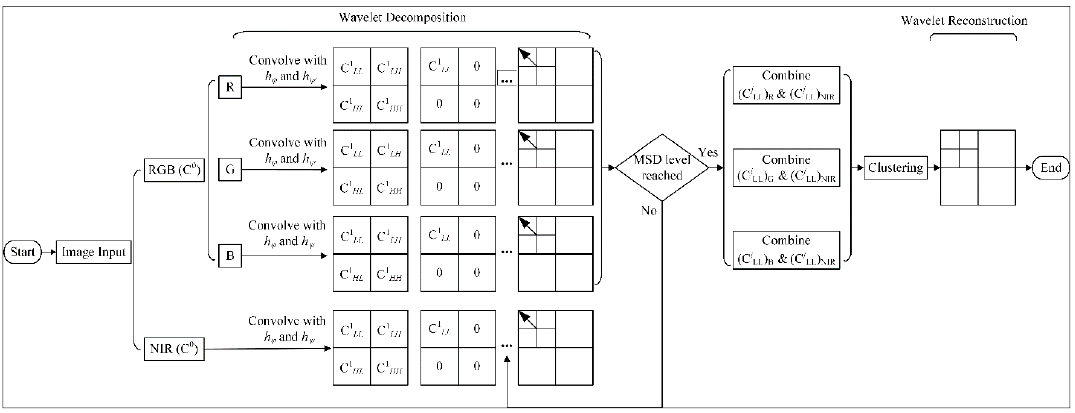
Figure 5. Fusion on color and near infrared images with DWT.